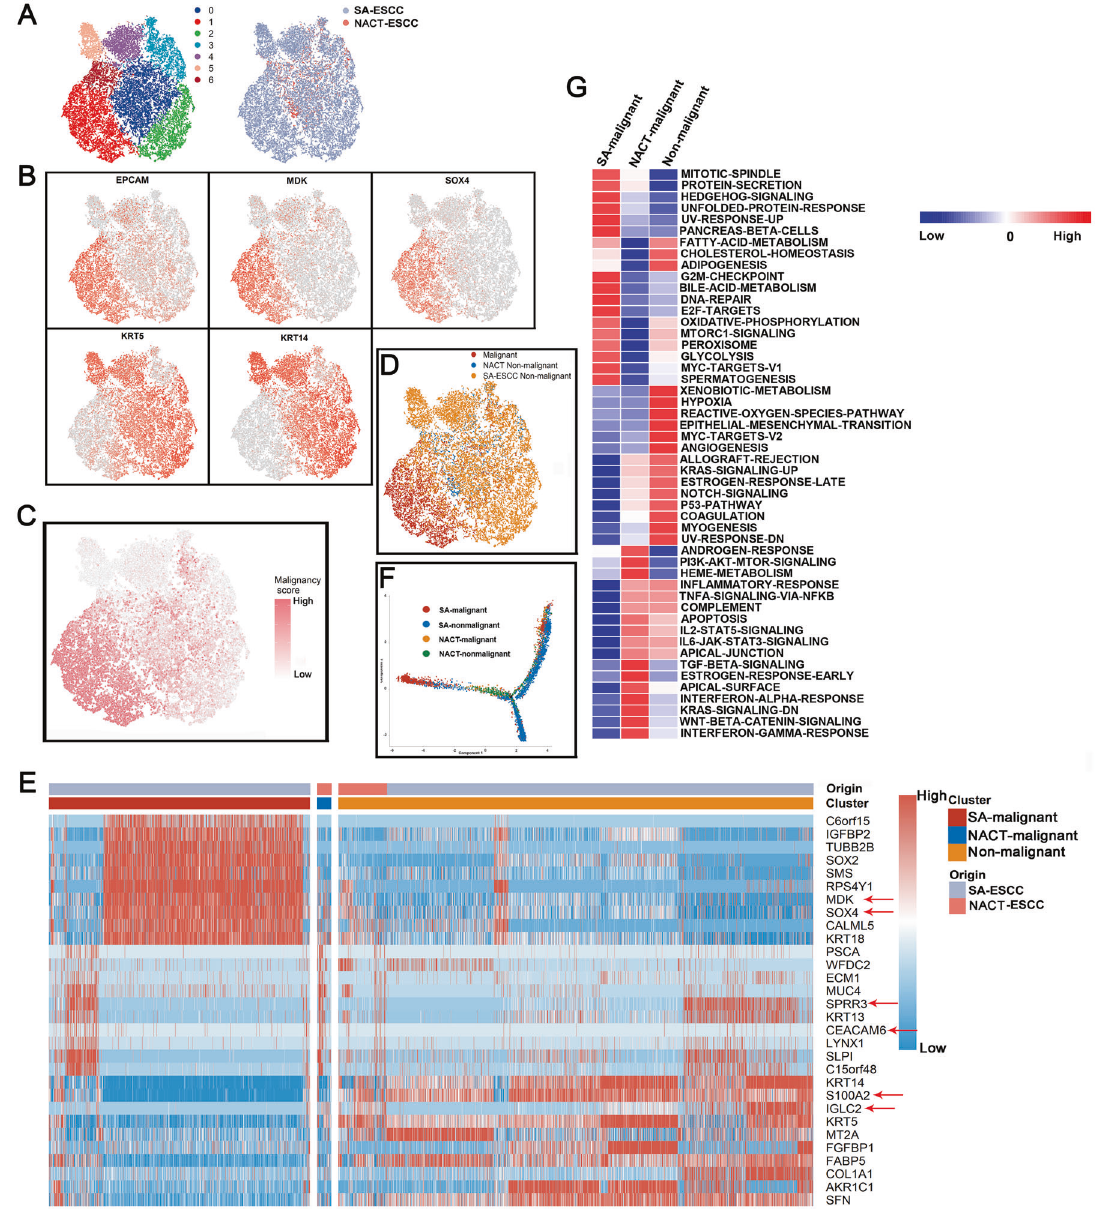
Fig. 2 The single-cell transcriptomes of epithelial cells in non-malignant and malignant esophagus. A The TSNE plot and overview of the 90,606 epithelial cells, each cell has color code for its cluster and origin of sample type. B Expression of marker genes for each epithelial subtype. C The TSNE plot of epithelial cells colored based on the malignancy scores of the cells. D The TSNE plot of epithelial cells colored based on the cell type. E Expression of marker genes for SA-malignant, NACT-malignant, and Non-malignant cells. F Unsupervised transcriptional trajectory of malignant and normal epithelial cells from Monocle2 colored by cell type. G Differences in pathway activities scored per cell by GSVA among different epithelial cells subtypes. Normalized pathways